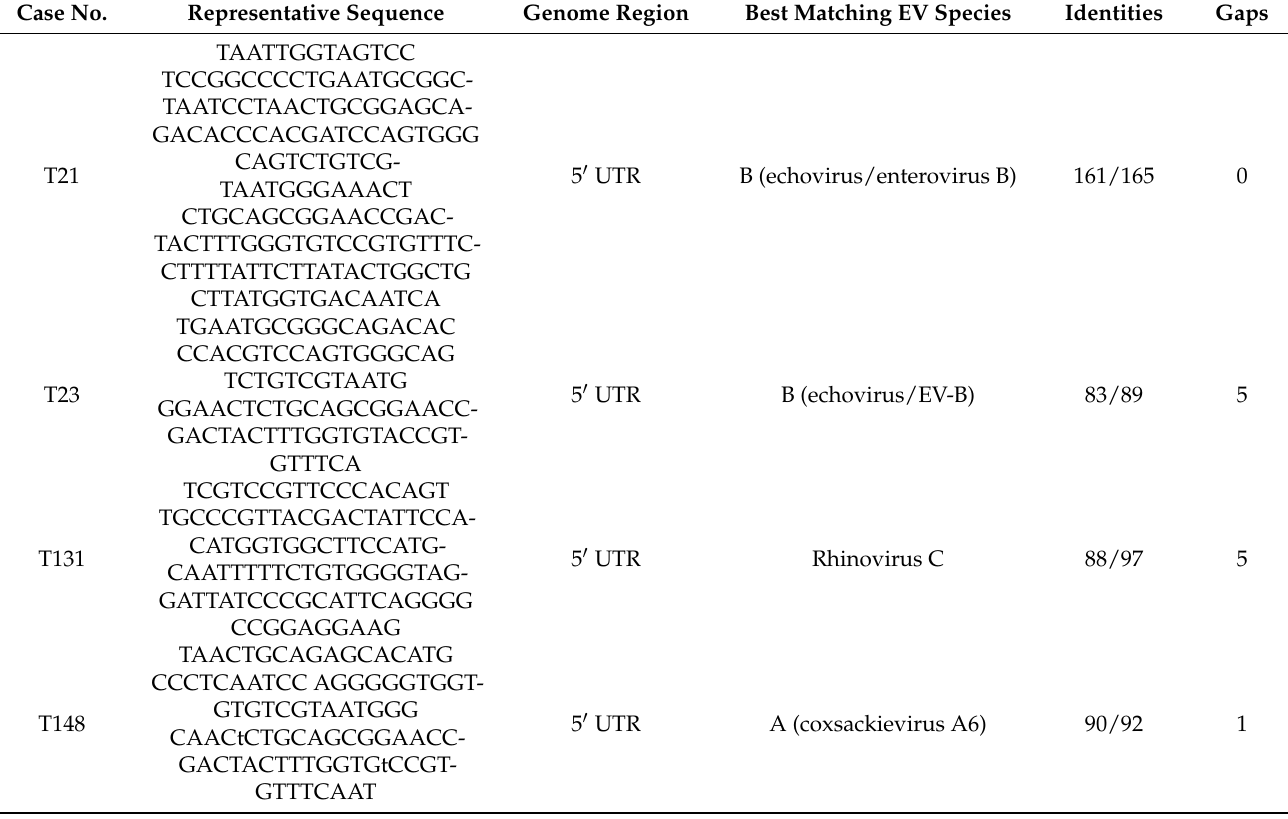
Table 2. Partial RNA genome sequences of enterovirus strains obtained from thyroid tissue of patients with autoimmune thyroid disorders. Case